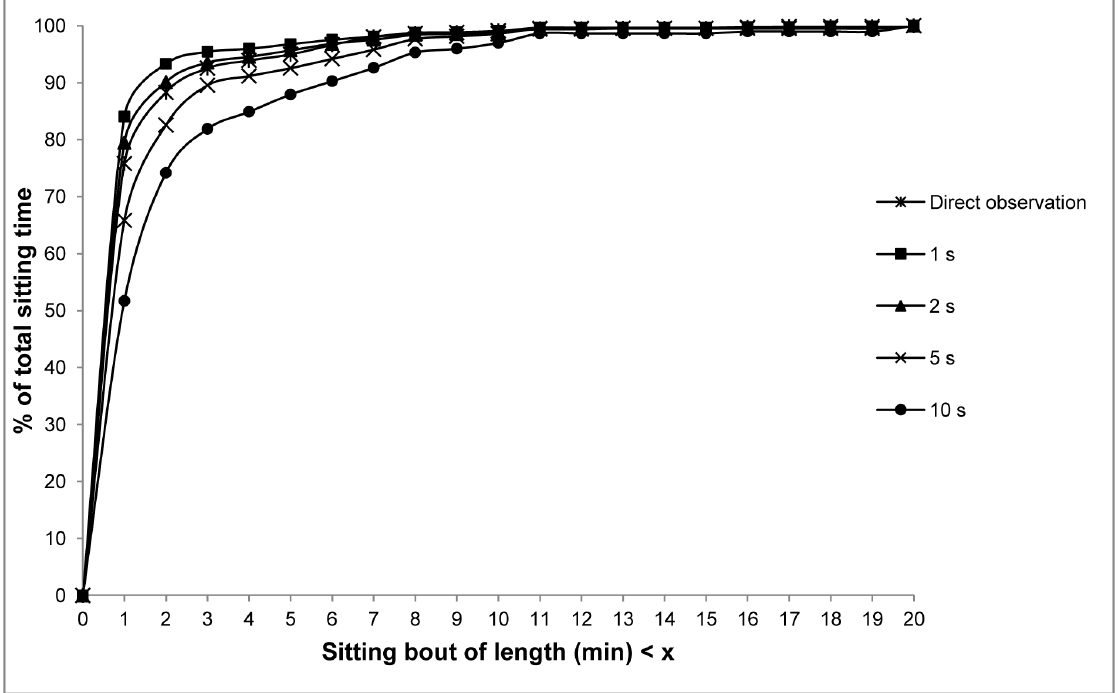
Figure 3. The pattern of accumulation of sitting bouts during direct observation, using minimum sitting/upright periods of 1s, 2s, 5s and 10s. Study 2 (n=30). The numbers on the x-axis are cumulative – hence the y intercept at a particular x value represents the number of sitting bouts occurring shorter than or equal to a given x axis value.